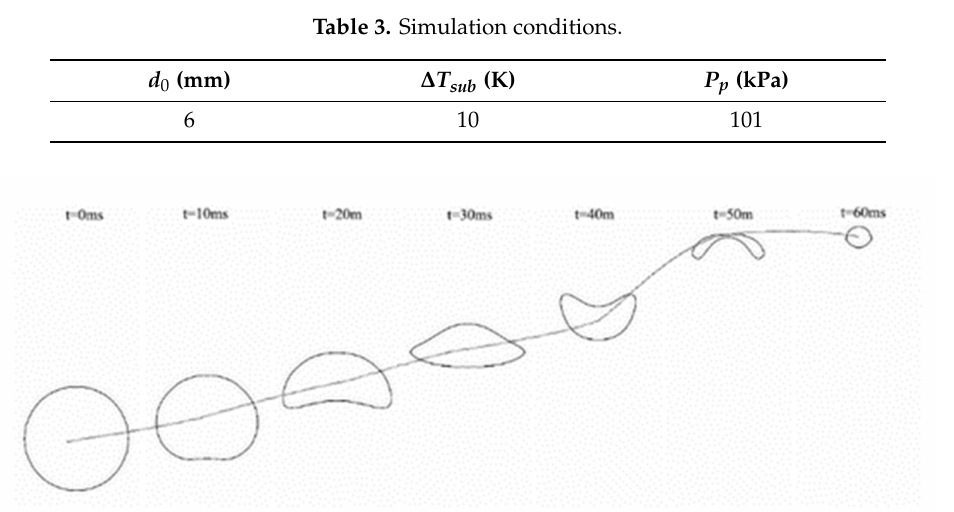
Figure 8. Variation diagram of bubble